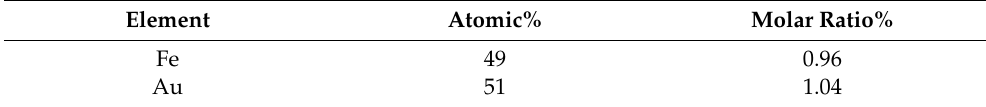
Table 2. Molar ratio analysis using ICP.